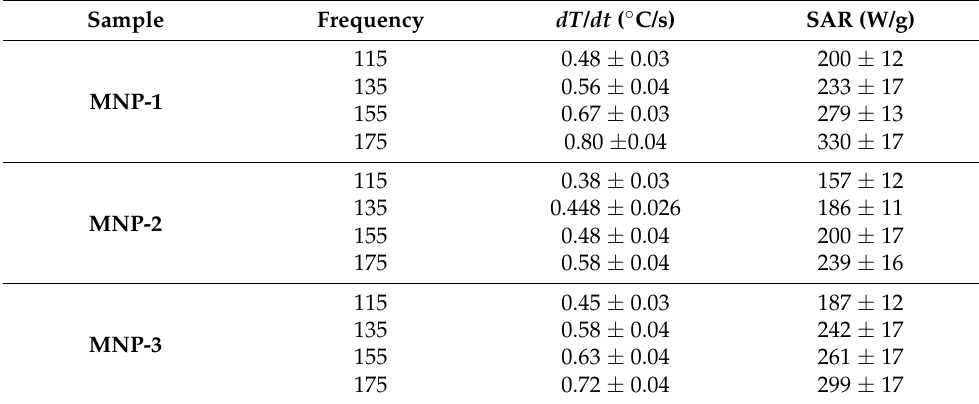
Table 1. SAR values of the MFHT of the samples investigated. The uncertainties correspond to 95% confidence intervals in the slopes and the